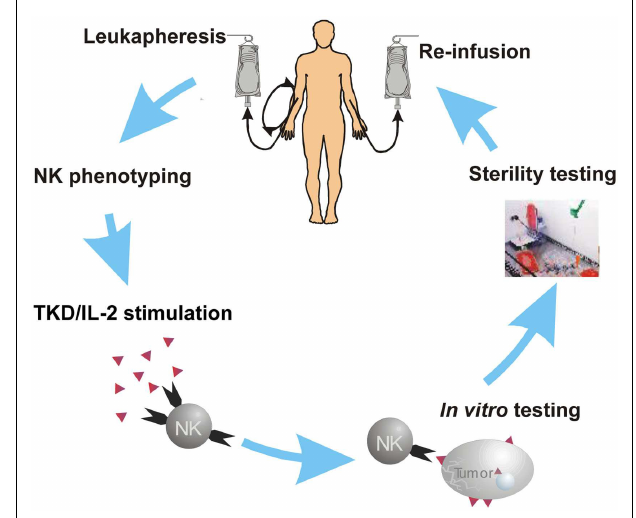
FIGURE 1 | Scheme of the NK cell activation in the clinical phase I trial . NSCLC patients after radiochemotherapy undergo leukapheresis and the immune phenotype (NK cell andT cell markers) is assessed by flow cytometry. Following erythrocyte depletion on a SEPAX system peripheral blood lymphocytes (PBLs) are stimulated ex vivo in a GMP laboratory with TKD/IL-2 for 3–5days. After measuring of NK activation markers and sterility testing, the activated cells are washed and re-infused (i.v.) in the